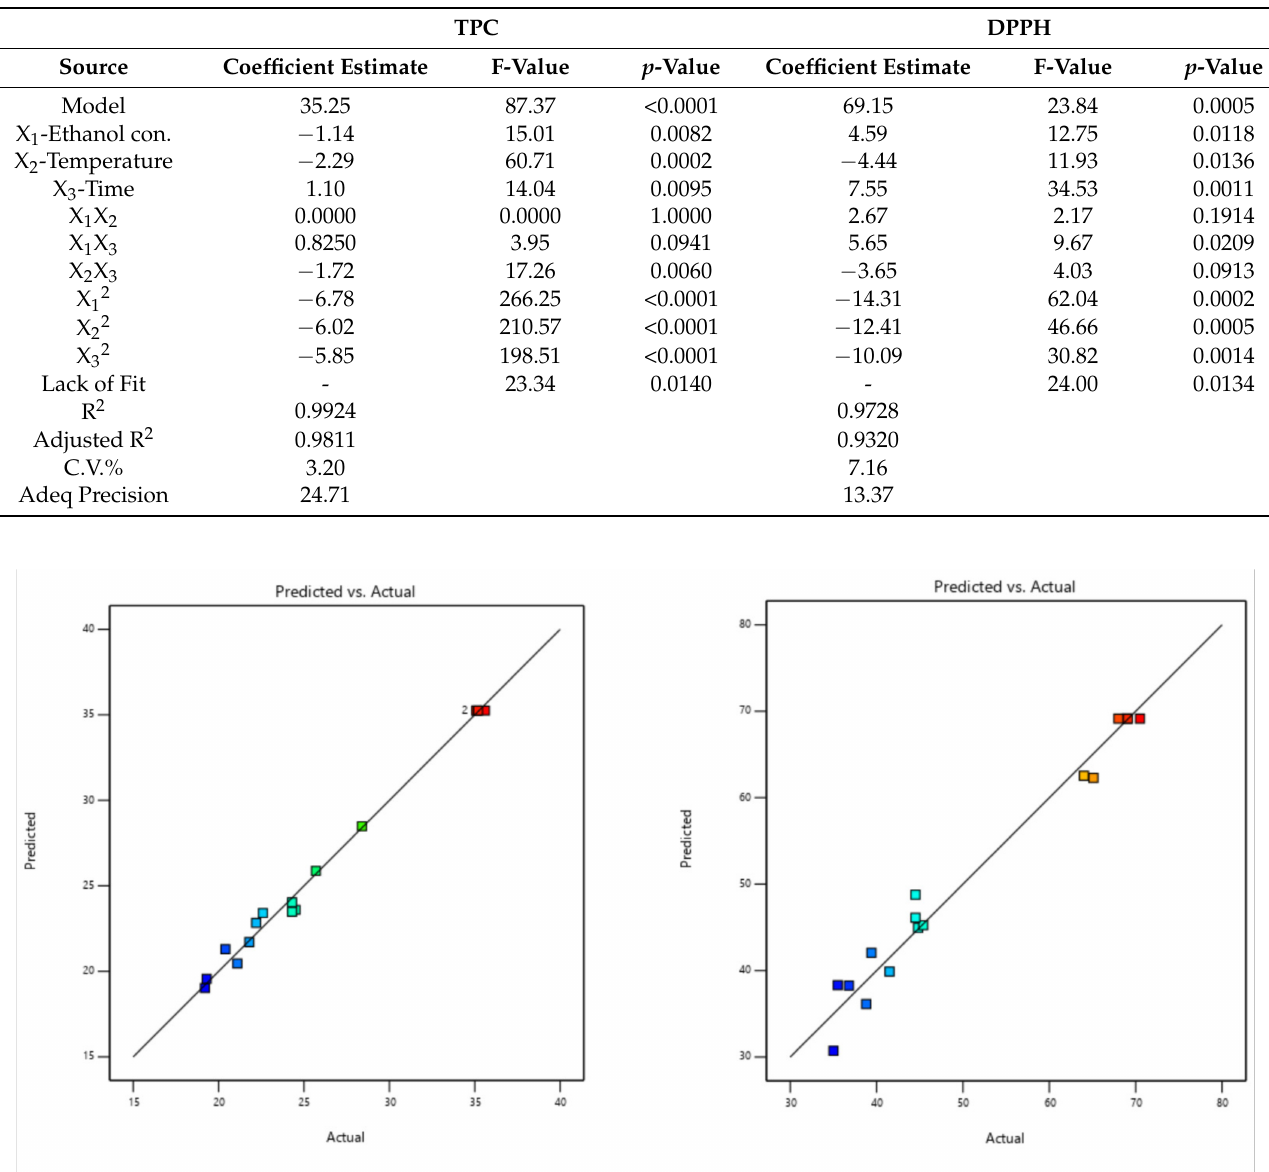
Table 2. Analysis of variance for the regression model of TPC and DPPH.